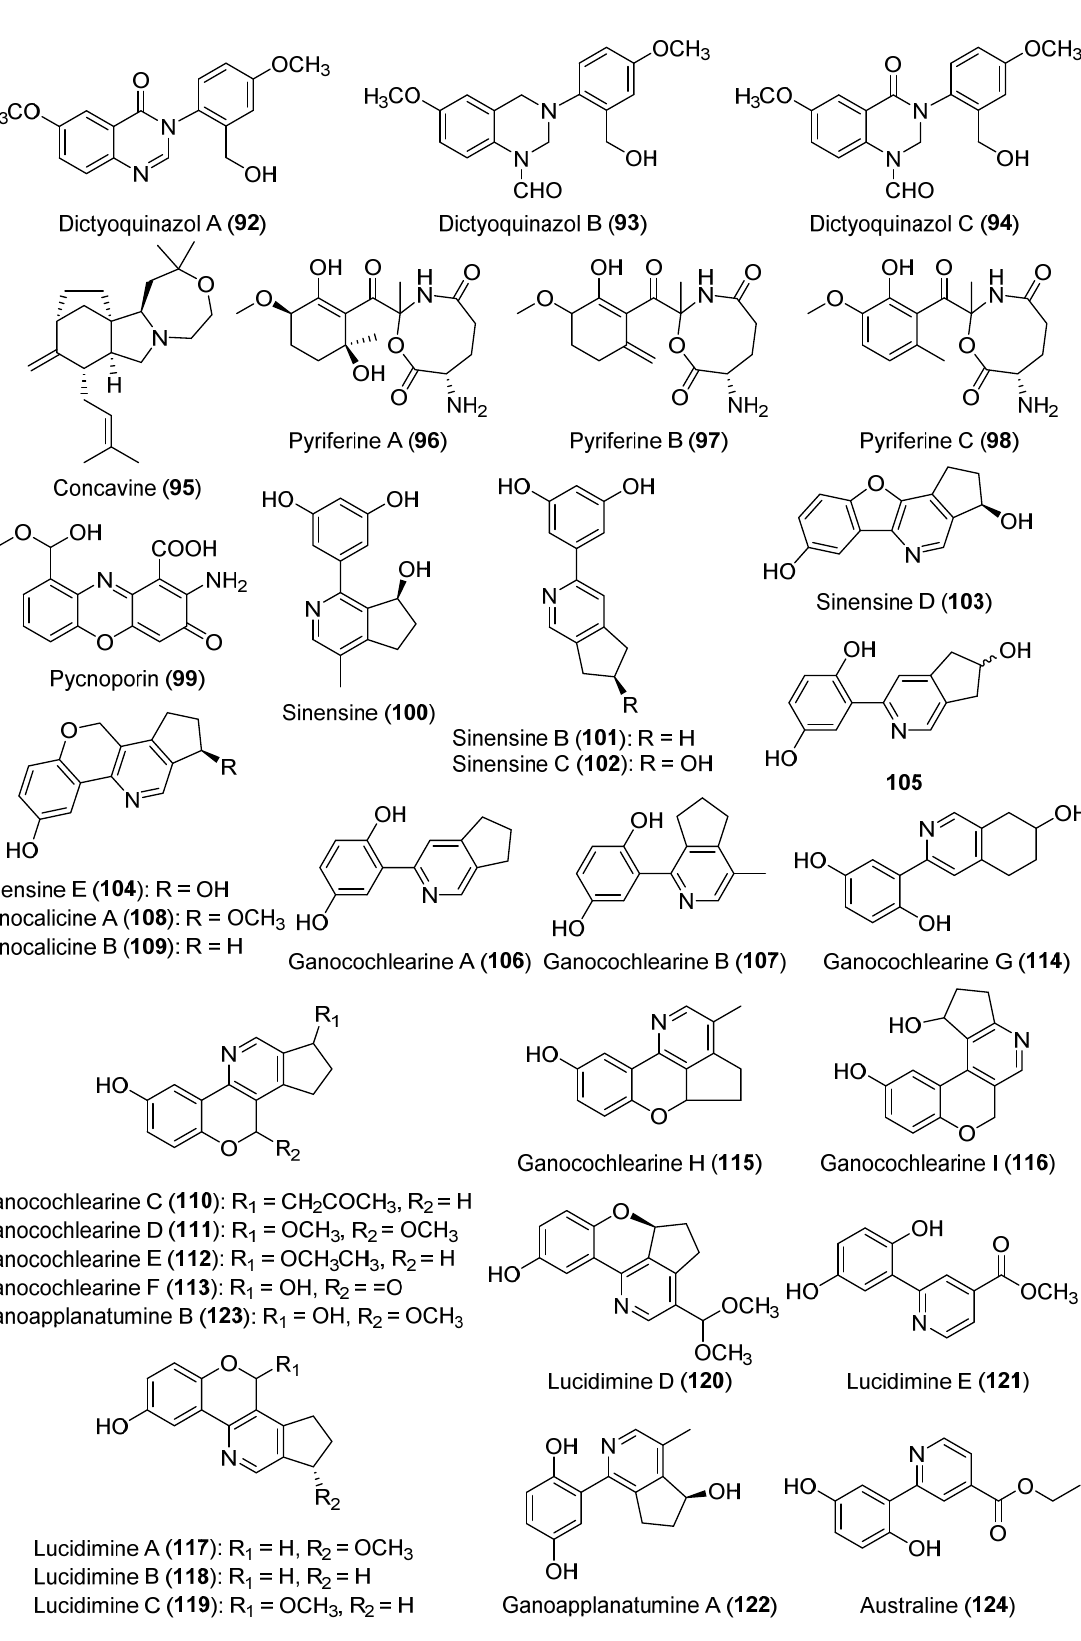
Figure 7. The structures of the miscellaneous alkaloids 92 – 124 .